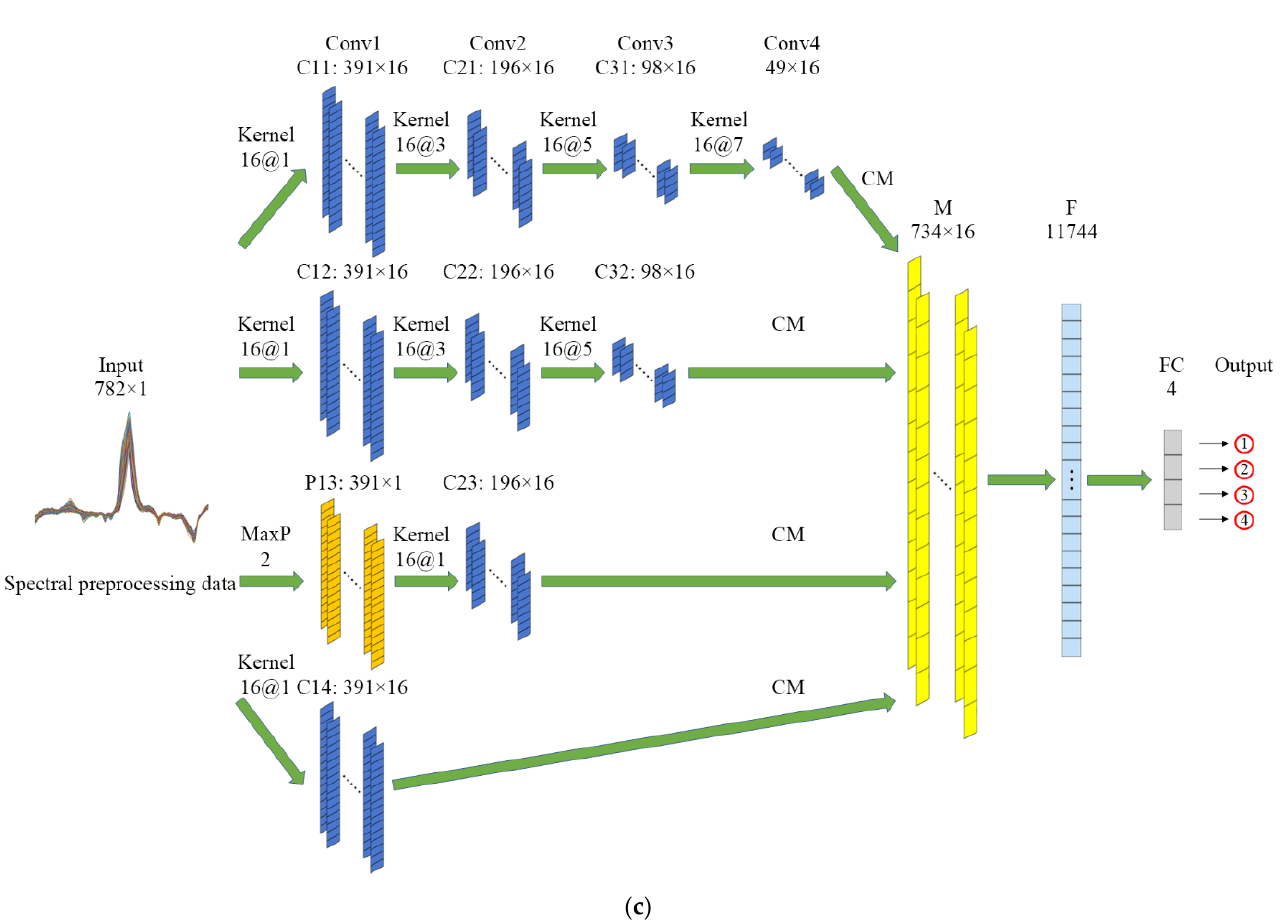
Figure 3. 1D-CNN model architecture. ( a ) Single-depth convolution; ( b ) Symmetric multiscale convolution; ( c ) Asymmetric multiscale convolution. Here, 782 × 1 represents the model input as 1D spectral vector with a length of 782; Kernel 16@1 represents the convolution operation, the number of convolution filters is 16, the length of the 1D convolution window is 1; MaxP 2 represents the max pooling operation, the size of the max pooling window is 2; l × d represents the dimensionality of the feature vector as a network layer output, the length and depth of the feature vector are l and d, respectively; n represents the number of neurons in layer FC.